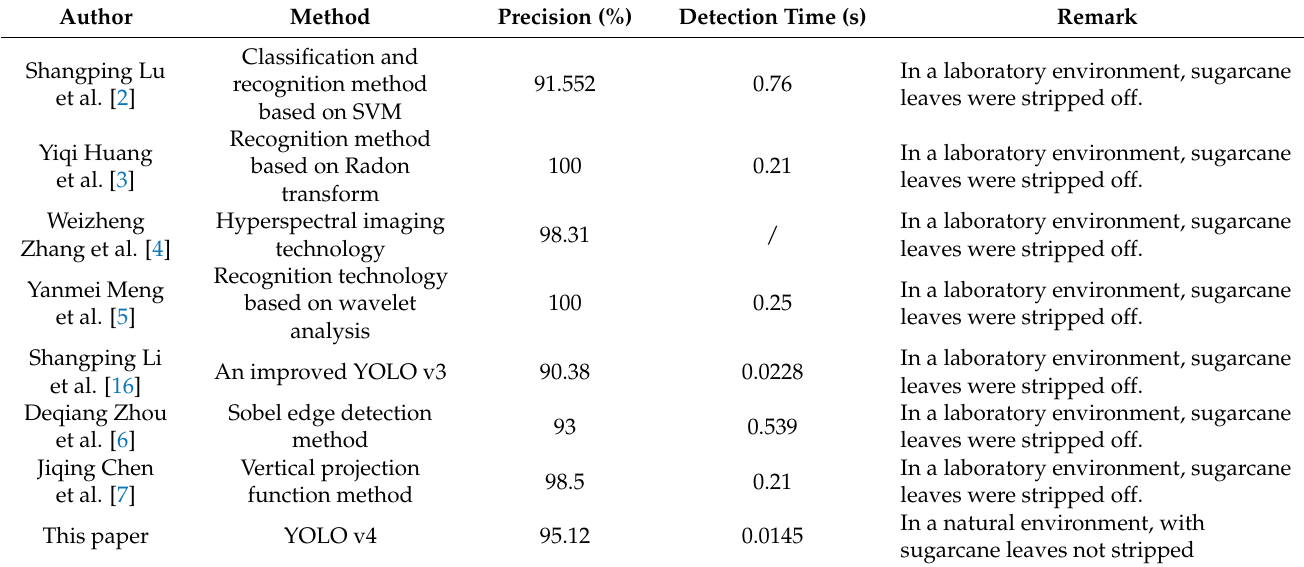
Table 1. Related research on sugarcane stem node